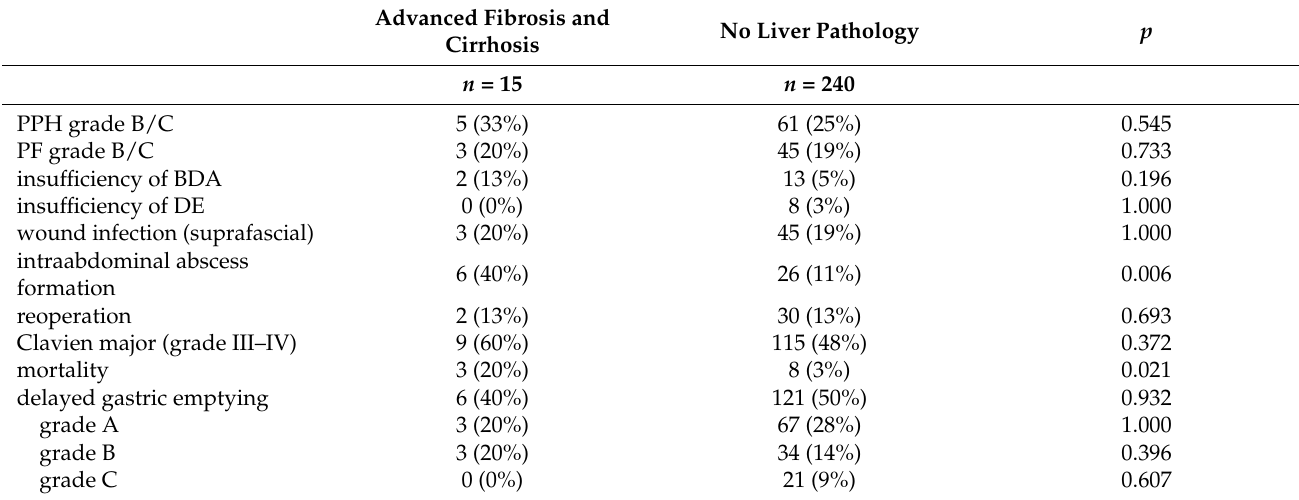
Table 2. Postoperative